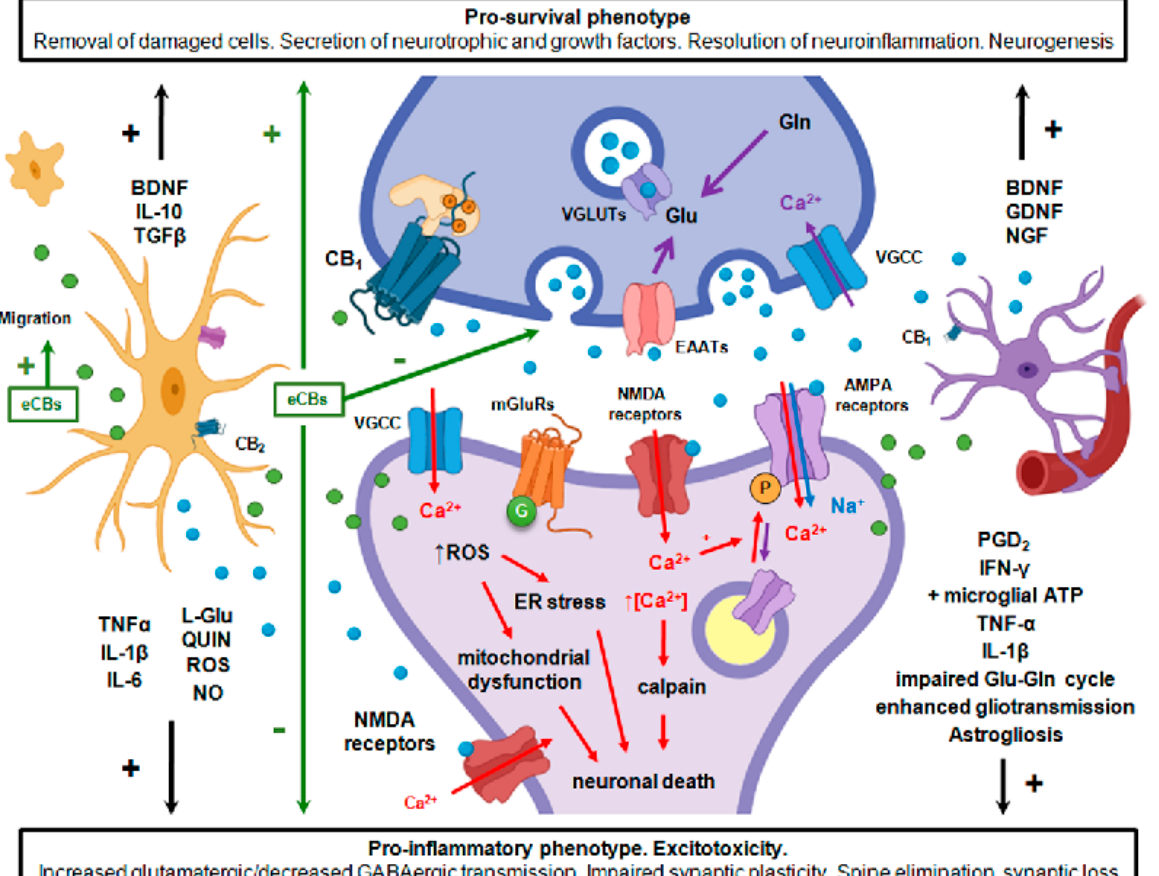
Figure 4. The development of synaptic dysfunction and the involvement of the ECS in neuroprotective responses. Endocannabinoid produced in the glutamatergic synapse under excitotoxic conditions attract microglial cells into close proximity to spines. By adopting a pro-inflammatory or pro-survival phenotype microglia largely define the fate of the injured cells and spines. eCB signaling decrease the presynaptic neurotransmitter release, support the glutamate–glutamine cycle, and balanced glutamate/GABAergic transmission. AMPA, α -amino-3-hydroxy-5-methyl-4-isoxazolepropionic acid receptor; BDNF, brain-derived neurotrophic factor; CB, cannabinoid receptor; EAATs, excitatory amino acid transporters; eCBs, endocannabinoids; ER, endoplasmic reticulum; GDNF, glial cell line-derived neurotrophic factor; Gln, glutamine; Glu, glutamic acid; IFN γ , interferon gamma; IL, interleukin; mGluRs, metabotropic glutamate receptors; NGF, nerve growth factor; NMDA, N-methyl-D-aspartate receptor; NO, nitrogen monoxide; PGD 2 , prostaglandin D 2 ; QUIN, quinolinic acid; ROS, reactive oxygen species; TGF β , transforming growth factor-beta; TNF α , tumor necrosis factor alpha; VGCC, voltage-gated calcium